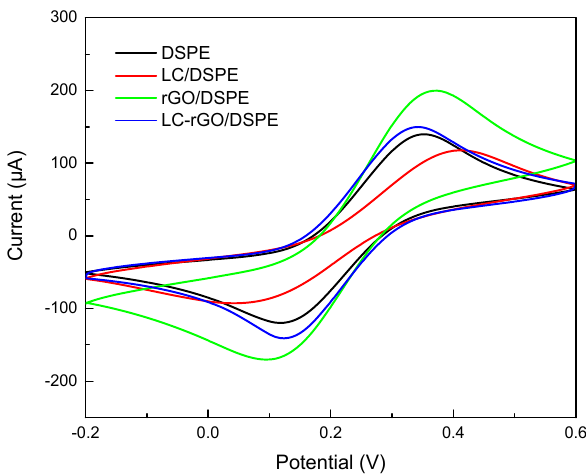
Figure 2. Cyclic voltammograms of the DSPE, L ‐ cysteine (LC)/DSPE, reduced graphene oxide (rGO)/DSPE and LC ‐ rGO/DSPE in 5 mmol/L [Fe(CN) 6 ] 3 − /4 − containing 0.1 mol/L of KCl with a scan rate of 50 mV/s.